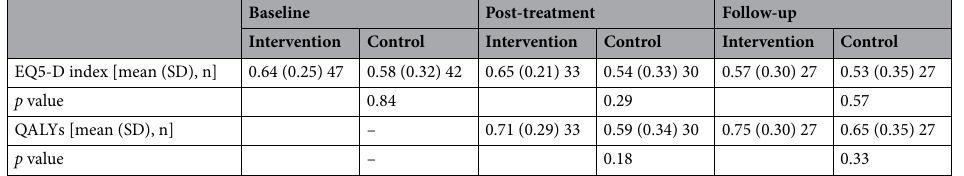
Table 3. Differences between groups measured with EQ5-D index and QALYs.